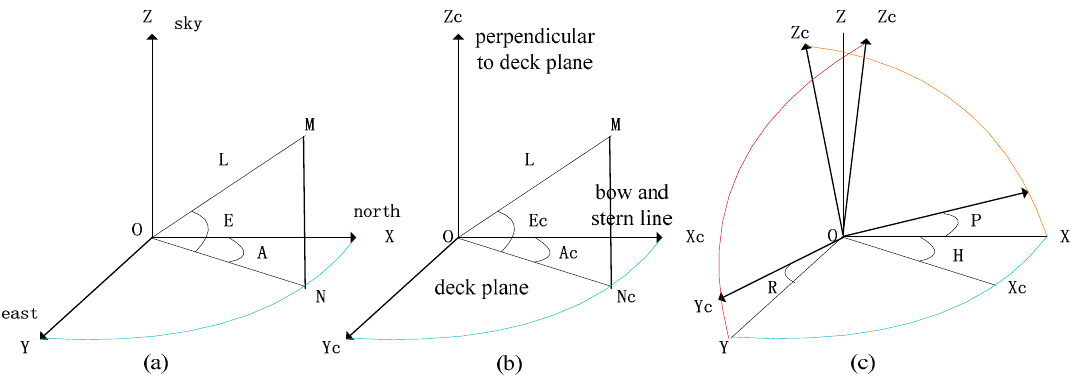
Figure 2. Schematic diagram of coordinate system and attitude angle. ( a ) The Northeast celestial coordinate system O-XYZ. ( b ) The deck coordinate system O − X c Y c Z c . ( c ) Definition of attitude angle.